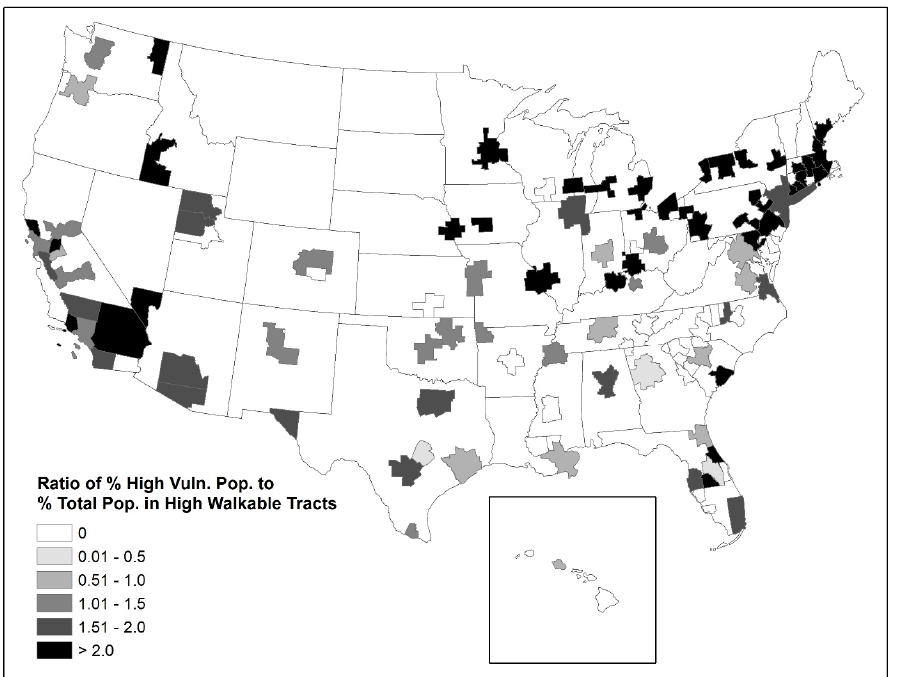
Figure 7. Ratio of the percentage of urban population residing in high (80th percentile)-socially vulnerable (SV) census tracts also residing within highly walkable (walk score ≥ 70) census tracts to the percentage of all urban population living in highly walkable tracts (i.e., “walk equity”) by metropolitan area.